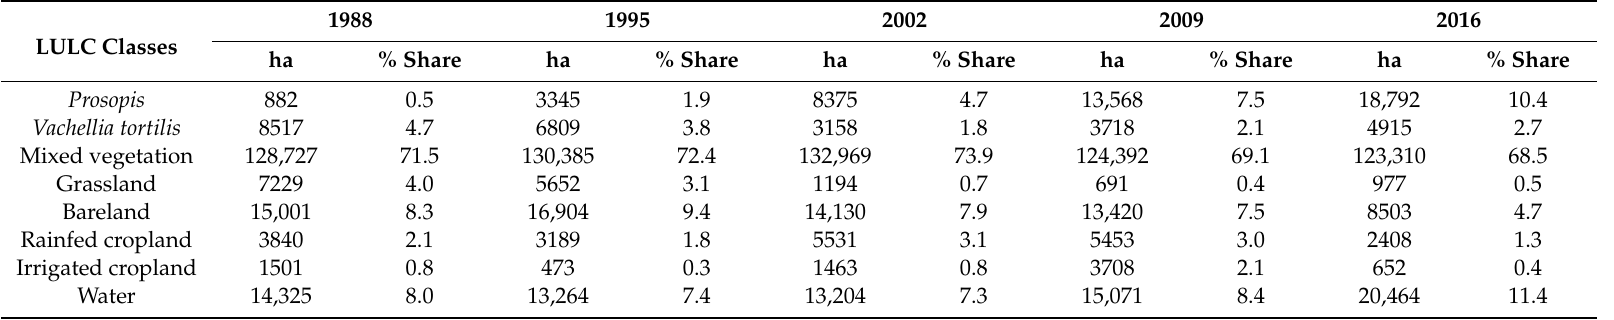
Table 3. LULC proportions for each class in hectares (ha) and percent share of the total area for 1988, 1995, 2002, 2009, and